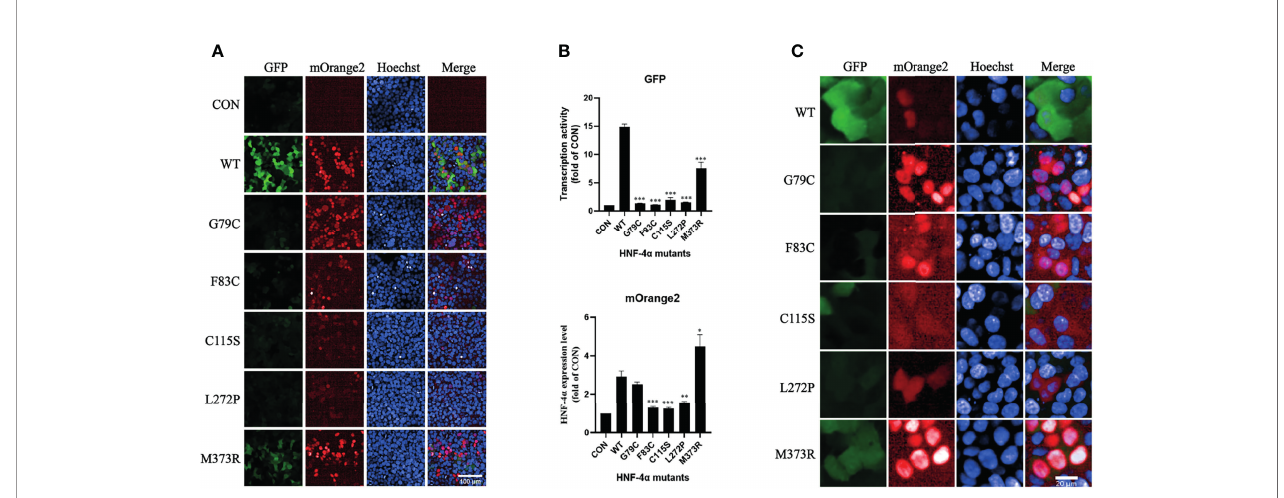
FIGURE 4 | Validation of the library mutants individually in HCS with confocal mode. (A) Evaluation of the transcription activity, expression level, and localization of HNF-4 a wild type or mutants using the HCS image. HEK293T_pHNF1AP_E9 cells transfected with wild-type HNF-4 a or different mutants as indicated for 72 h. GFP corresponds to the transactivists ’ ability, and mOrange2 represents the expression of HNF-4 a or mutants. Scale bar: 100 m m. (B) Quantitative of the transcription activity and expression level of all the plasmids in the library we used. Shown is the fold change of GFP and HNF-4 a -mOrange2 intensity. All data were presented as mean ± SD (n = 3 fi elds, and experiments were conducted twice independently. Statistical signi fi cance between WT and mutants (G79C, F83C, C115C, L272P, M373R) is indicated as asterisks: *p < 0.05, **p < 0.01, ***p < 0.001 (Student ’ s t-test). (C) Cellular localization of the wild type or mutants of HNF-4 a . Representative cells were shown except for three mutants (F83C, C115C, and L272P) which cells with higher mOrange2 intensity were selected for more details. Scale bar: 20 m